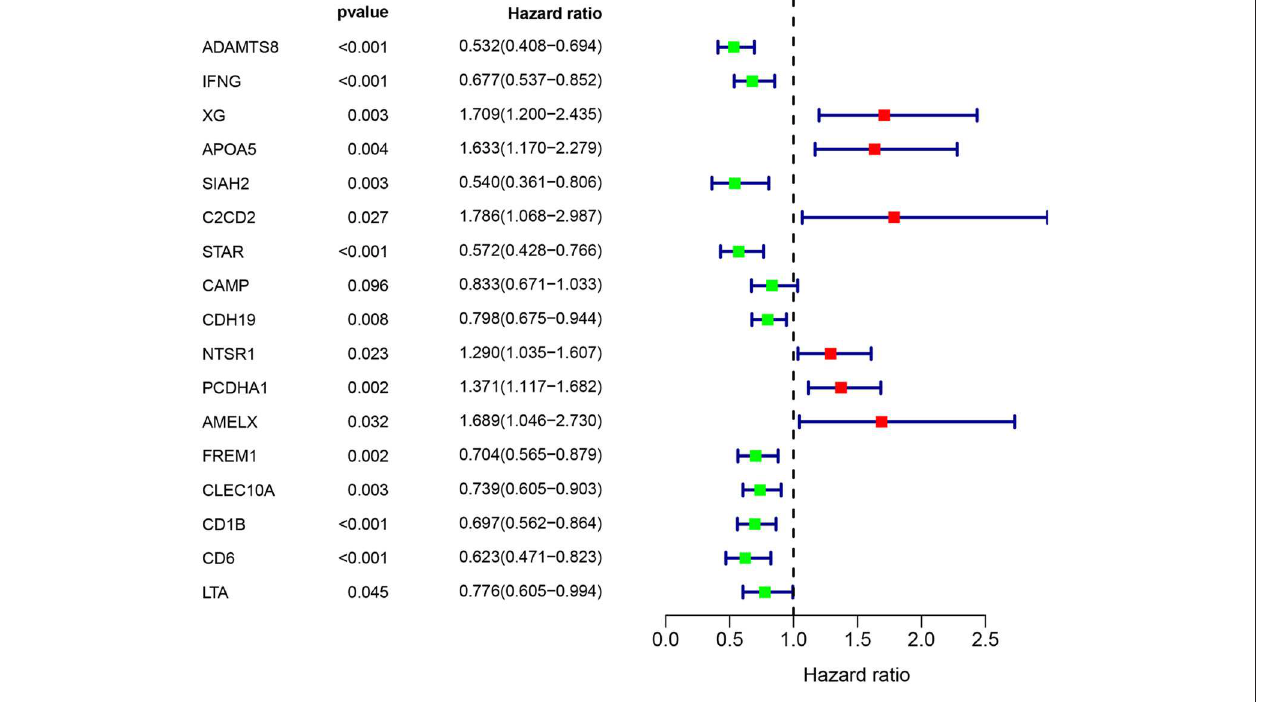
FIGURE 4 | Immune gene survival forest